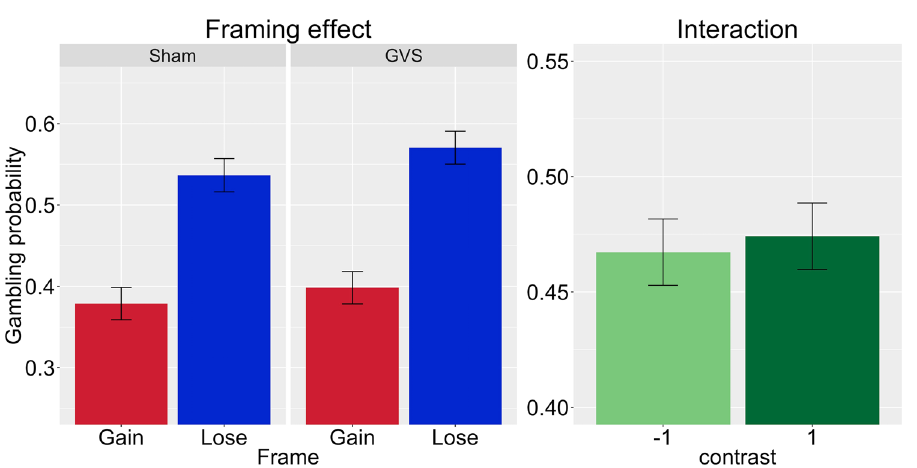
Figure 2. Results of Experiment 2: The left figure shows the framing effect as a function of galvanic vestibular stimulation (right anodal/left cathodal GVS) condition. The right figure shows the interaction term using contrast coding. Using a hierarchical logistical regression model, we found no significant interaction between stimulation and framing condition in Experiment